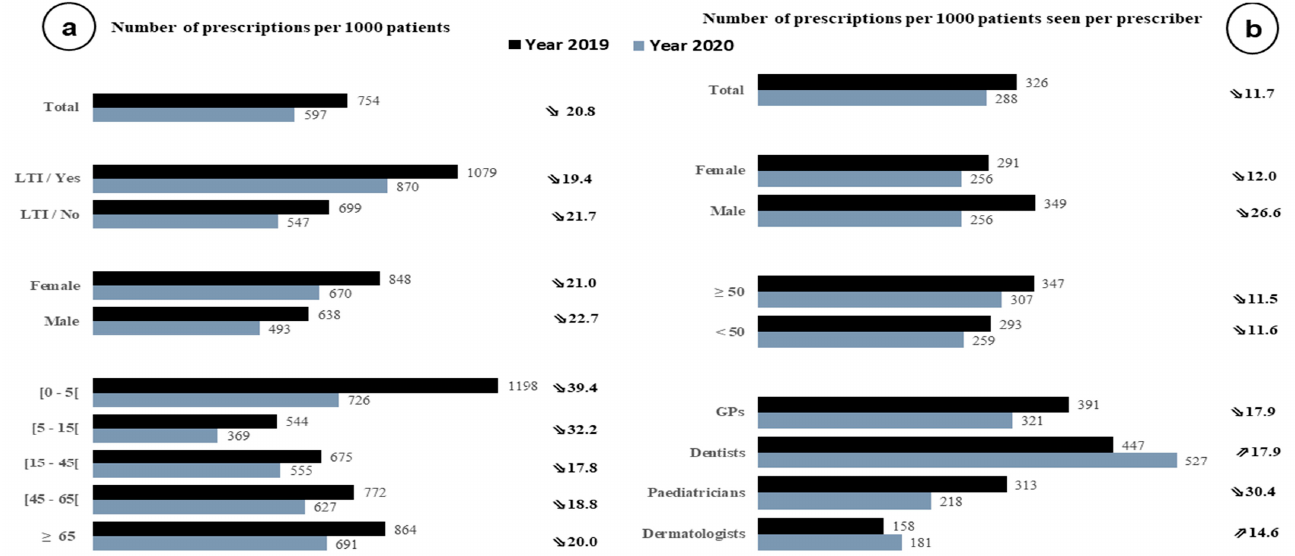
Figure 3. Antibiotic prescription rate ( a ) according to age, sex, presence of comorbidities (long-term illness, LTI) among patients; ( b ) according to age, sex, and subspecialty of prescribers—2019 and 2020, SNDS. To the right of each figure is the percentage (%) change in the indicators in 2020 compared to 2019.